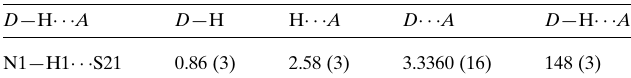
Table 1 Hydrogen-bond geometry (A˚ , (cid:2) ) for 1 .